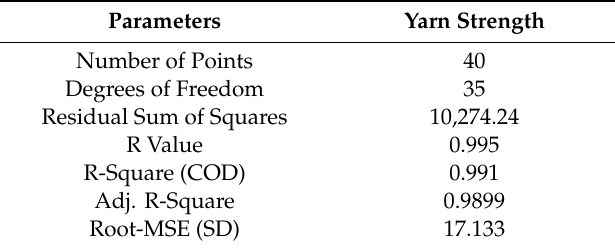
Table 11. Parameters of e ffi ciency of the regression model of variable Yarn strength.